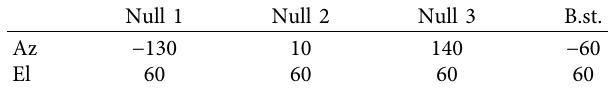
Table 6: Nulling and beam steering directions (in degrees). No- tation: Az, azimuth; El, elevation; B.st., beam steering direction.